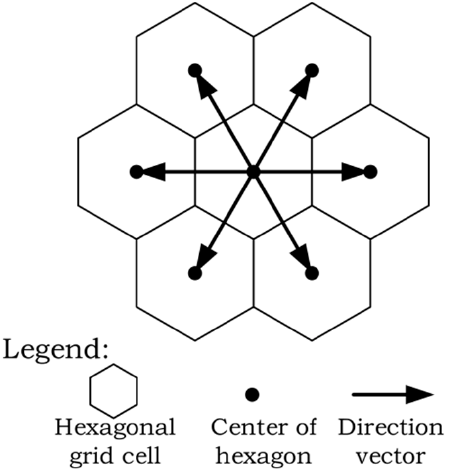
Figure 3. Direction vectors of a hexagonal grid.